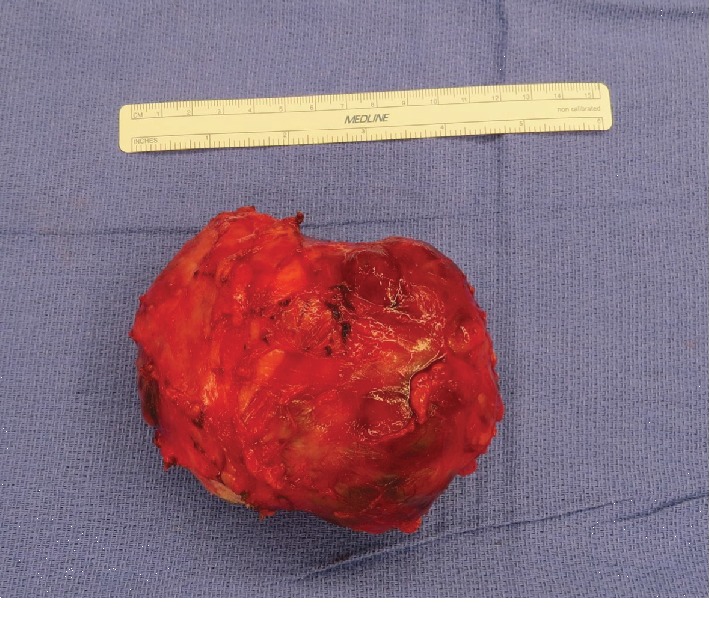
Intraoperative image of excised tumor measuring 12.5 cm.